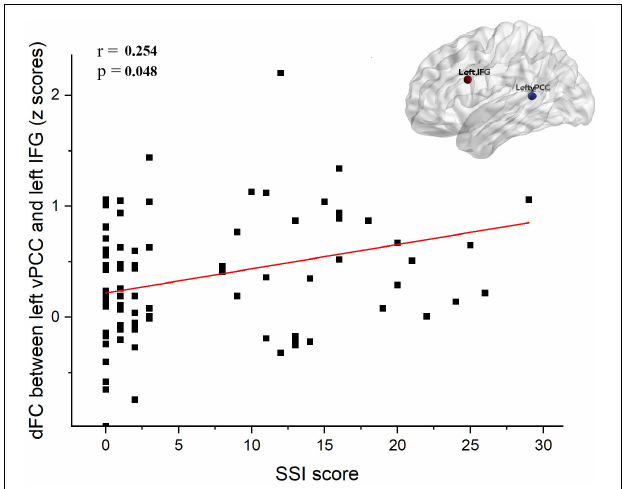
FIGURE 4 | Correlation analysis between dFC and SSI score in depressed subjects (i.e., SI group and NSI group). The dFC between the between left vPCC and left IFG was positively associated with SSI score ( r = 0.254, Bonferroni-corrected p = 0.048). SI, major depressive patients with suicidal ideation; NSI, major depressive patients without suicidal ideation; dFC, dynamic functional connectivity; vPCC, ventral posterior cingulate cortex; IFG, inferior frontal gyrus; SSI, scale for suicide